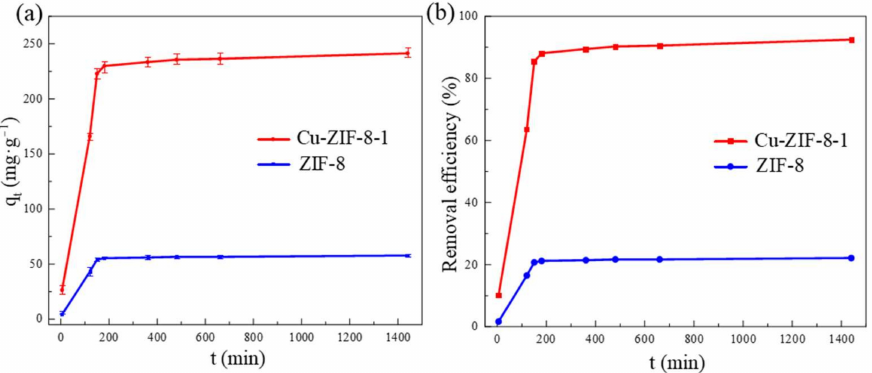
Figure 4. Adsorption amounts ( a ) and removal efficiency ( b ) of OFX as a function of time ( c 0 = 260 mg · L − 1